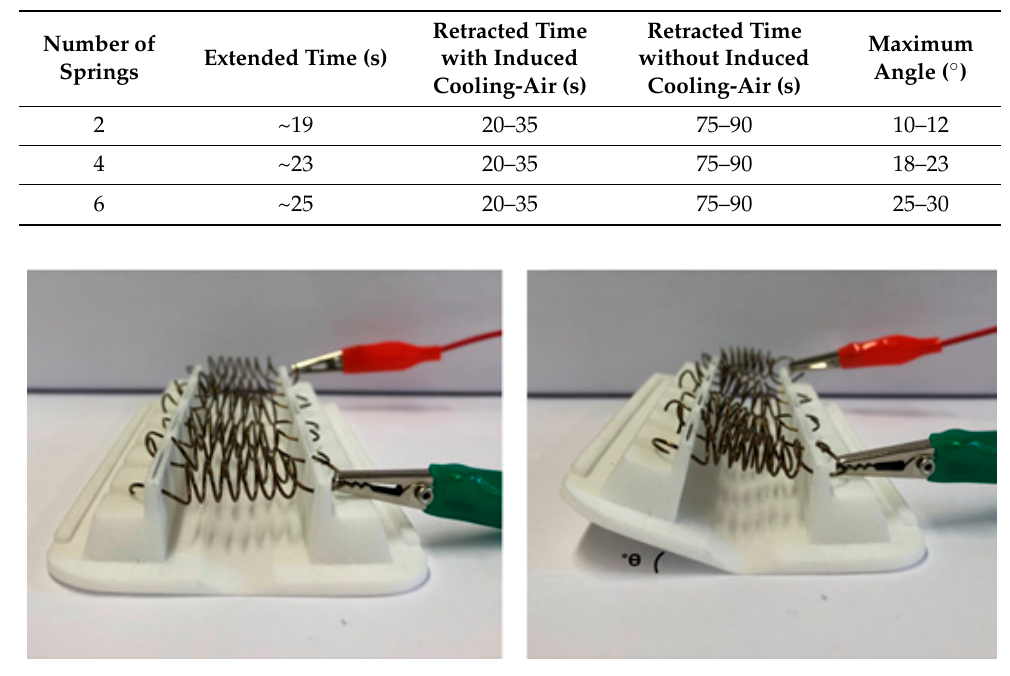
Figure 10. Evaluation of angle of inclination of the prototype.